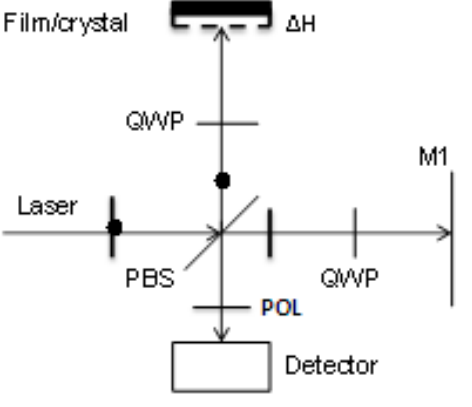
Figure 1. Optical configuration of the experimental setup for growth rate measurement p ( | ) and s (●) -polarization components are separated by a PBS [20].